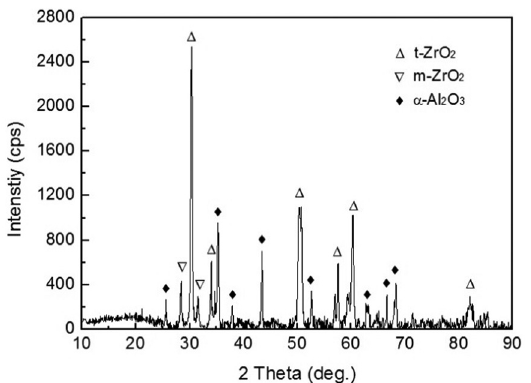
Figure 2. XRD pattern of the Al